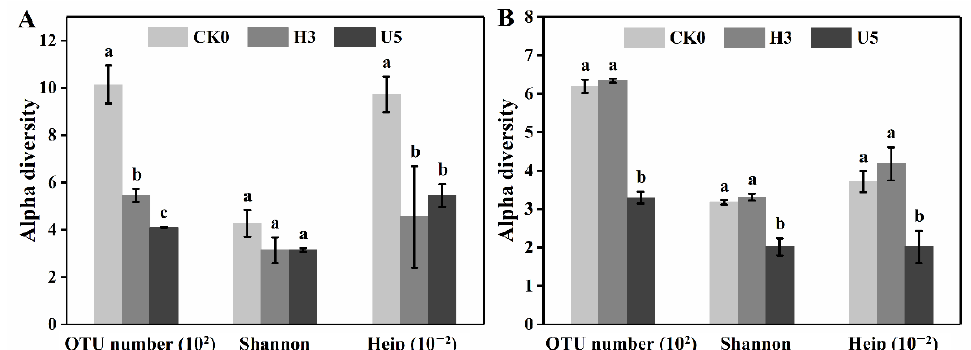
Figure 4. Alpha diversity changes of the bacterial ( A ) and fungal ( B ) community in the phyllosphere during the (ultra)high-level ozone exposure. OTU numbers, Shannon and Heip, are shown with error bars representing standard deviation ( n = 3). Different letters indicate significant differences (LSD test, p < 0.05).